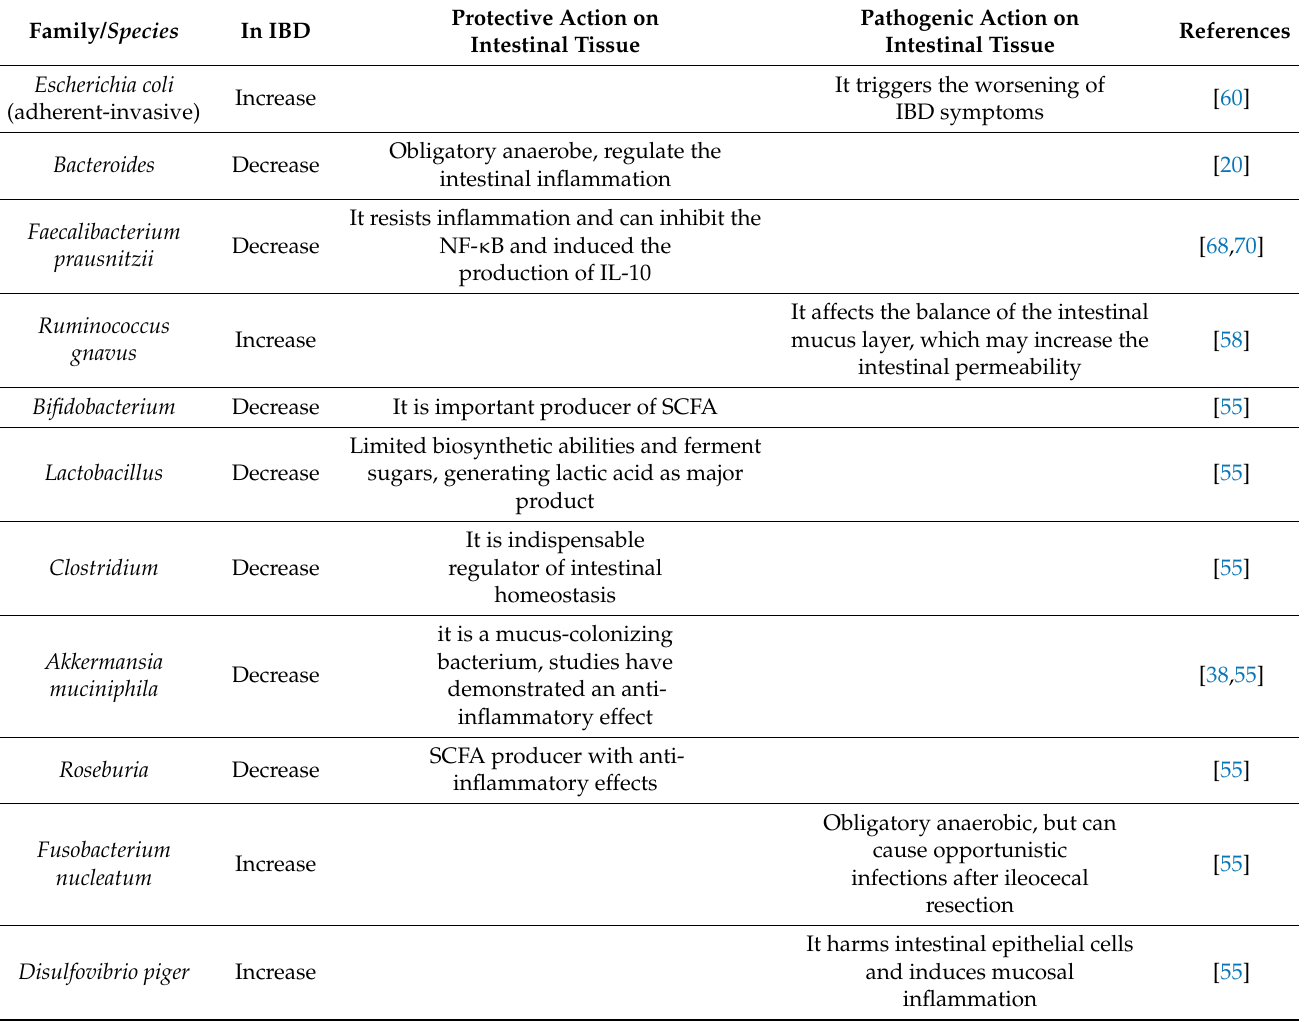
Table 1. The main bacteria involved in dysbiosis in Inflammatory Bowel Disease